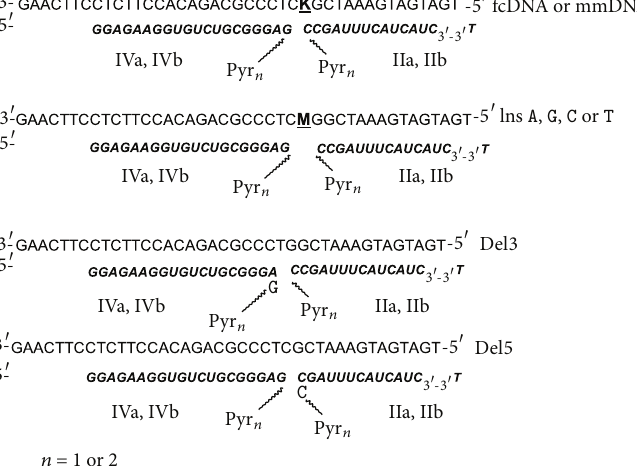
Figure 6: Multipyrene tandems for detection of SNP, mononucleotide insertions and deletions. N-Deoxyribonucleotide, 𝑁 -2 󸀠 -O- methylribonucleotide, K -G (fcDNA), or A (mmDNA), M -A, G, T, or C insertion; Del3 and Del5-DNA targets with mononucleotide deletion; InsA, InsG, InsC, InsG-DNA target with mononucleotide insertion (A, G, C, and G).